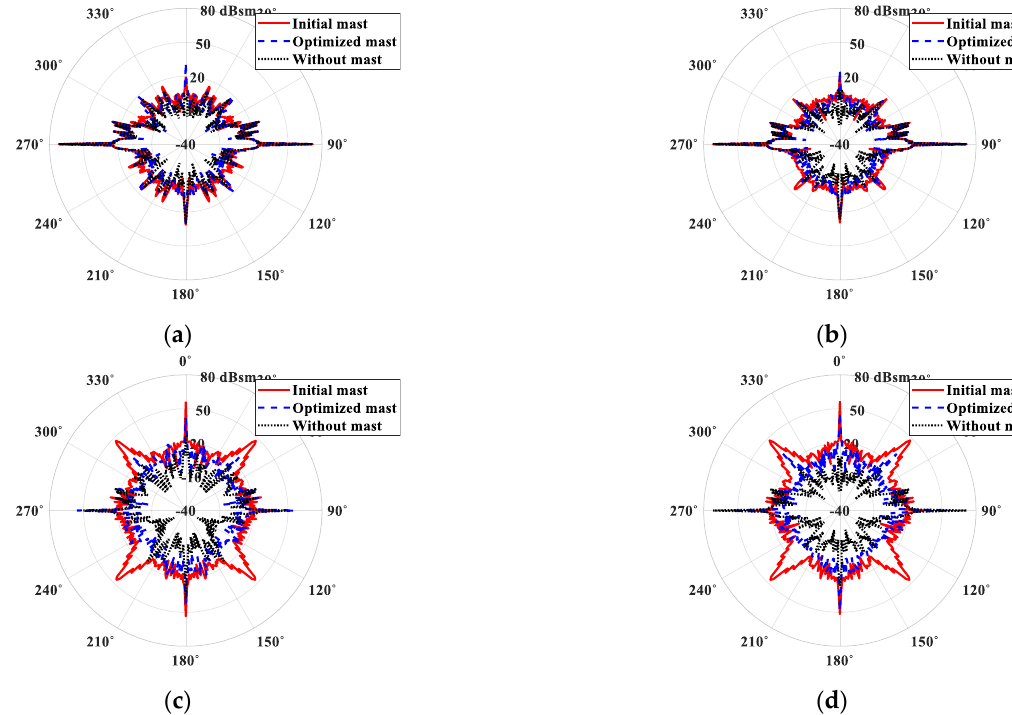
Figure 10. RCS pattern of a naval vessel equipped with the integrated mast in the azimuth plane in the L-band. ( a ) HH polarization at an elevation angle of 0°, ( b ) VV polarization at an elevation angle of 0°, ( c ) HH polarization at an elevation angle of 10°, ( d ) VV polarization at an elevation angle of 10°.